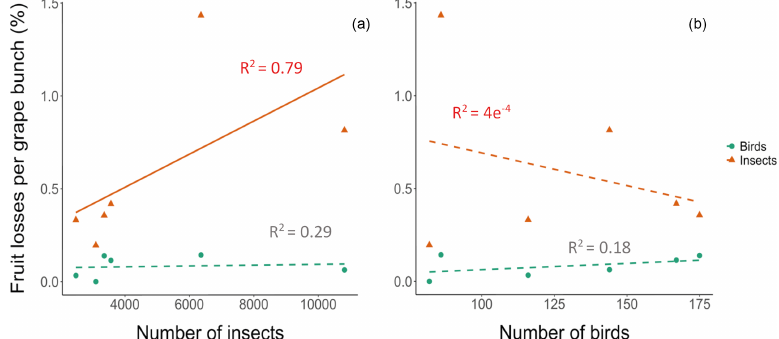
Figure 6. Relationships between the total number of insects (a) and birds (b) , and the mean fruit loss caused by birds and insects per vineyard. The solid regression lines represent significant